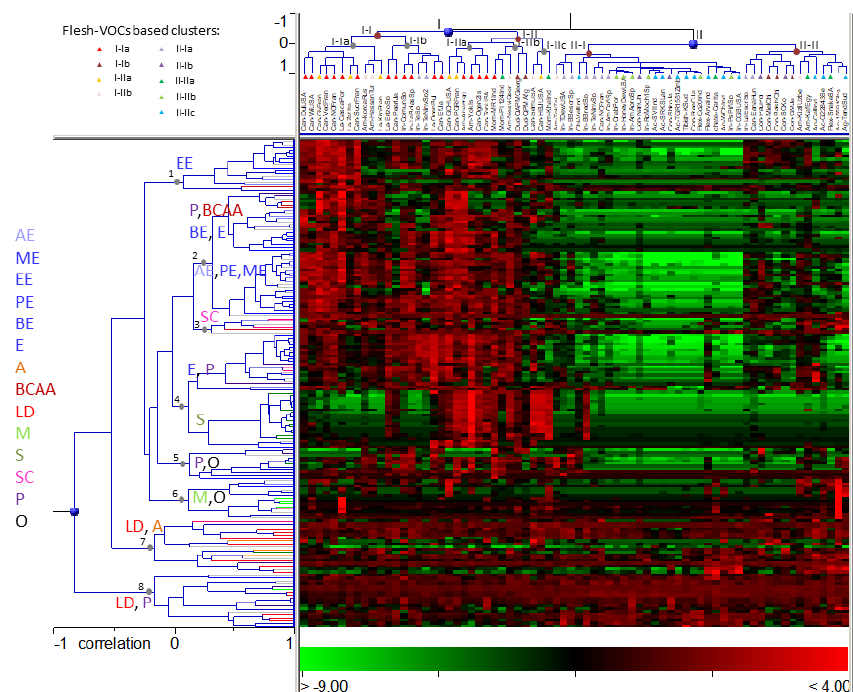
Figure 1. Hierarchical Cluster Analysis (HCA) and heatmap using rind volatile organic compound (VOC) data. Volatile clusters (1-8) and accessions clusters are indicated. HCA was constructed using the distance metrics based on the Pearson correlation. The red to green range of color in the heatmap indicates the level of each volatile in each sample according to the scale below (log 2 transformation of the ratio levels of each volatile in a sample/average of all the genotypes analyzed): light red for the highest values; light green, lowest; black, intermediate. Codes for VOCs are used (acetate esters AE, methyl esters ME, ethyl esters EE, propyl esters PE, butyl esters BE, other esters E, apocarotenoids A, branched chain amino acid related compounds BCAA, lipid derivatives LD, monoterpenoids M, sesquiterpenes S, sulfur compounds SC, phenolics P, and others O). Triangle colors are coded based on flesh-VOCs clusters by Esteras et al. [5].